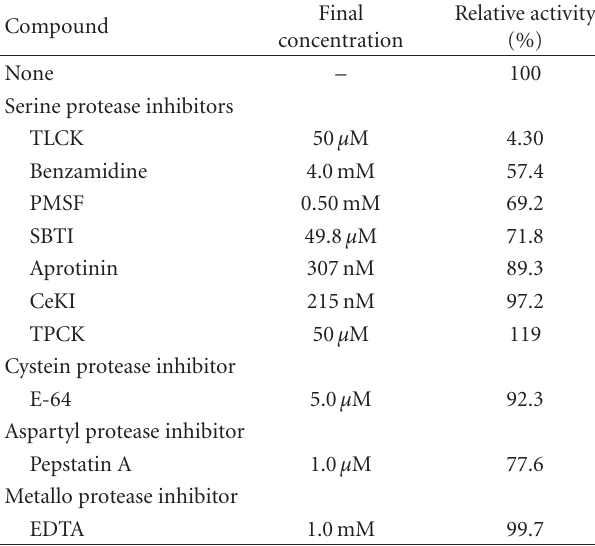
Table 3: E ff ects of some inhibitors on the CeSP